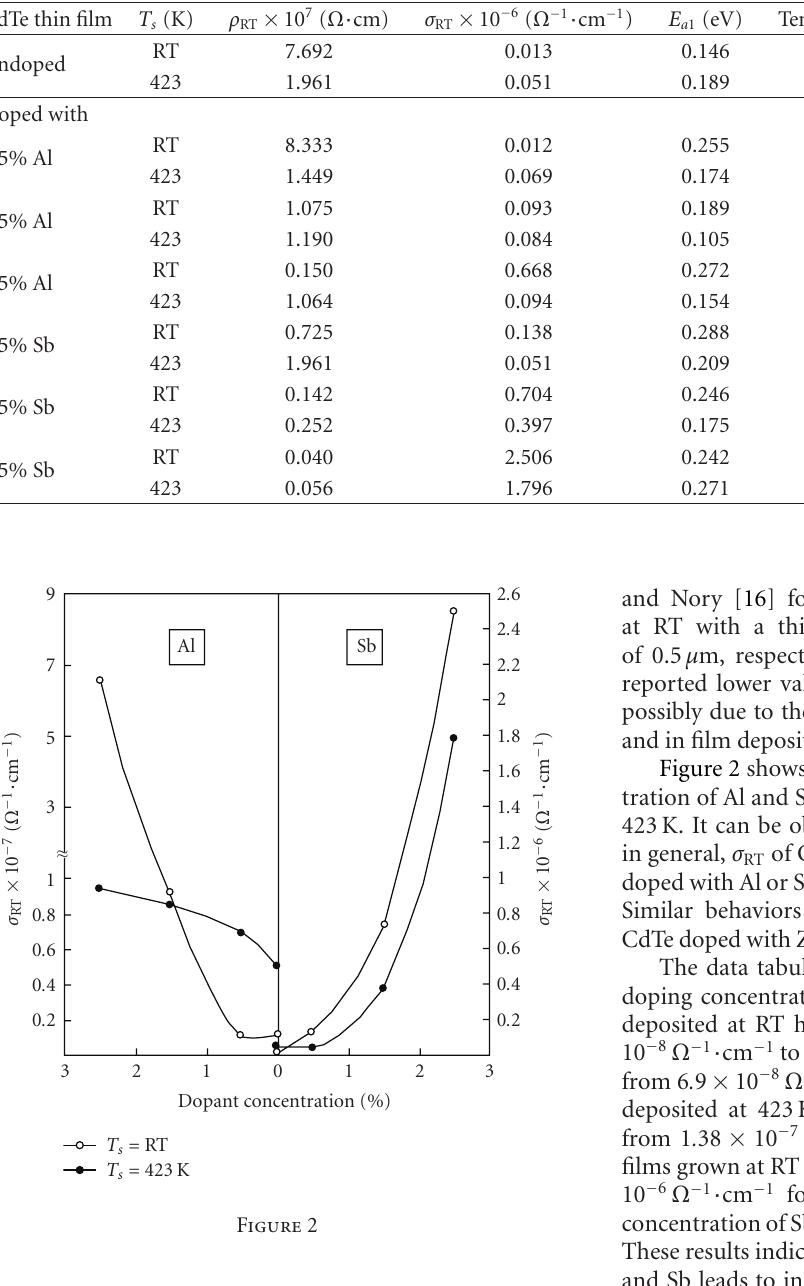
Table 1: Values of ρ RT , σ RT , E a 1 and E a 2 for undoped and doped CdTe thin films deposited at RT and 423